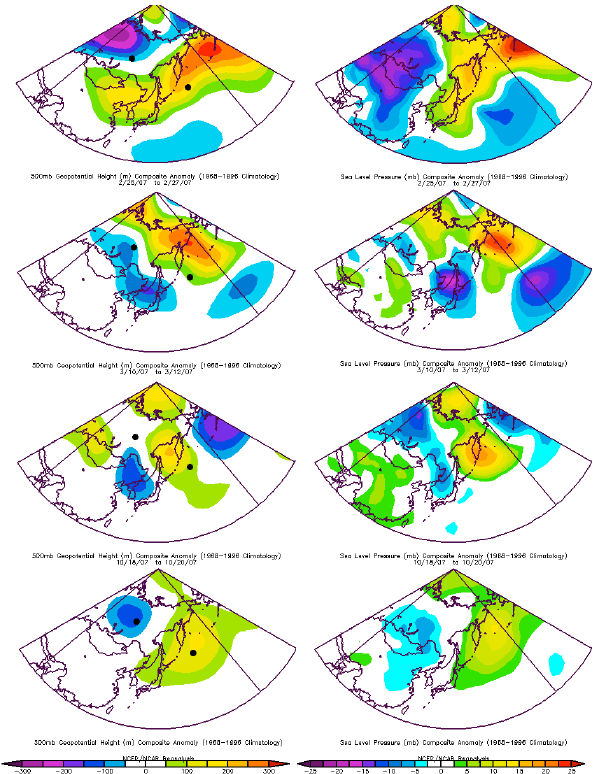
Figure 12. 500 hPa Geopotential height anomaly pattern (left panels) and Sea Level Pressure anomaly (right panels) for the 3-day initial stage of export to the Arctic of the three case studies discussed here: February 25-27, March 10-12, and October 18-20. Bottom panels: composite of all eleven episodes observed by CALIOP in 2007-2009. Two circles indicate the location of the two poles used to define the AME index. Images provided by the NOAA/ESRL Physical Sciences Division, Boulder Colorado from their Web site at http://www.esrl.noaa.gov/psd/.